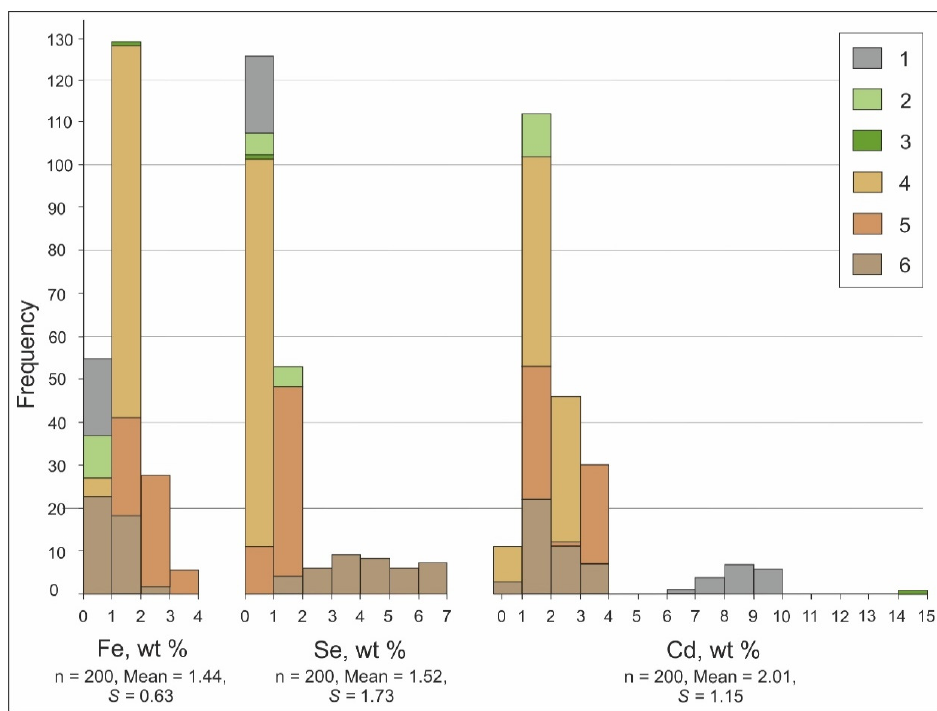
Figure 10. Histograms of Fe, Se, and Cd in ZnS from sedimentary (1) and CM (2–6) rocks. Summary of SEM-EDS, EPMA, and LA-ICPMS data. n = number of analyses, Mean = mean value, S = standard deviation. Statistical data calculated for ZnS from CM rocks. Samples: 1 = DOS, OSB; 2 = TH-11; 3 = TH-74; 4 = DT-20; 5 = DT-26; 6 = DT-25.